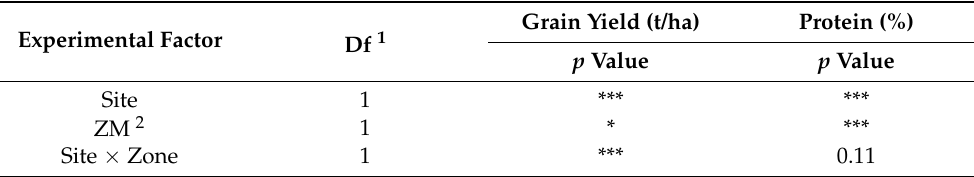
Table 11. Results of the ANOVA applied to the grain yield and protein content on the zone manage- ment experimental factor for both sites. Grain Yield (t/ha) Protein (%) Experimental Factor Df 1 p Value p Value Site 1 *** ZM 2 *** Site × Zone *** 0.11 1 df: Degree of freedom; ZM: Zone management; *: Significant at p < 0.05%; ***: Significant at p <